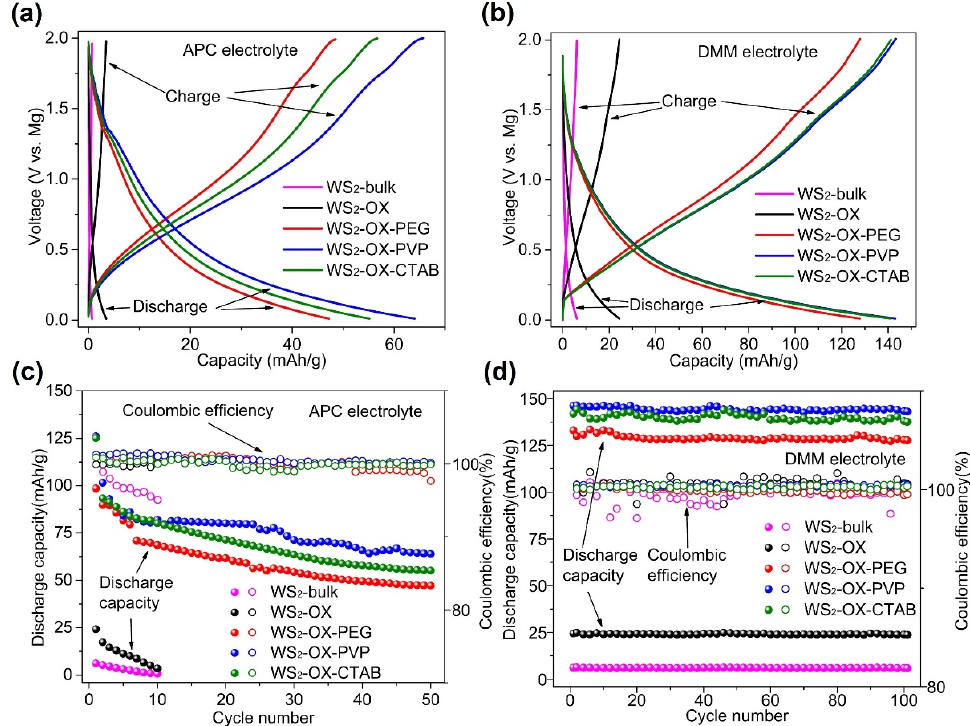
Figure 3. The discharge–charge profiles of different morphologies of WS 2 as magnesium battery cathodes in ( a ) APC and ( b ) DMM electrolyte at 500 mA/g after 100th cycle. ( c , d ) The cycling performance of different morphologies of WS 2 as magnesium battery cathodes in ( c ) APC and ( d ) DMM at 500 mA/g.